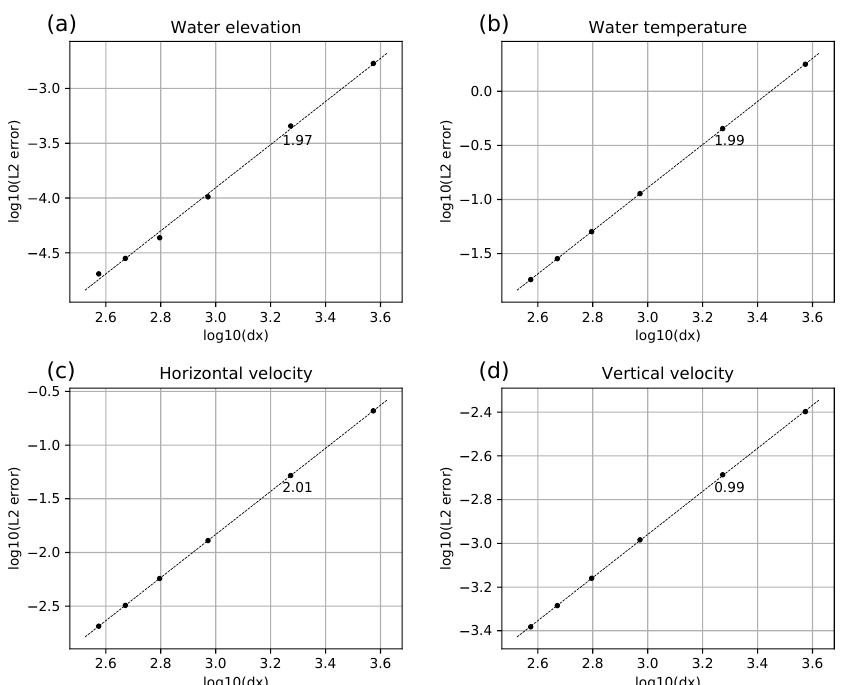
Figure 2. Convergence of the L 2 error in the baroclinic MMS test case. The mesh was refined 1, 2, 4, 6, 8, and 10 times, resulting in resolutions of 2500, 1250, 625, 416.67, 312.5, and 250m (shortest edge of the triangle). The time steps were 25.0, 12.5, 6.25, 4.167, 3.125, and 2.5s, respectively. The number indicates the slope of the least-squares best-fit line (dashed line).